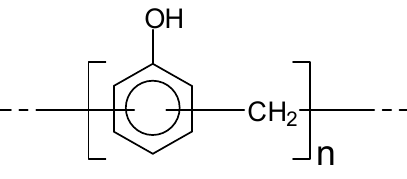
Scheme 3. Schematic representation of a PF resin.